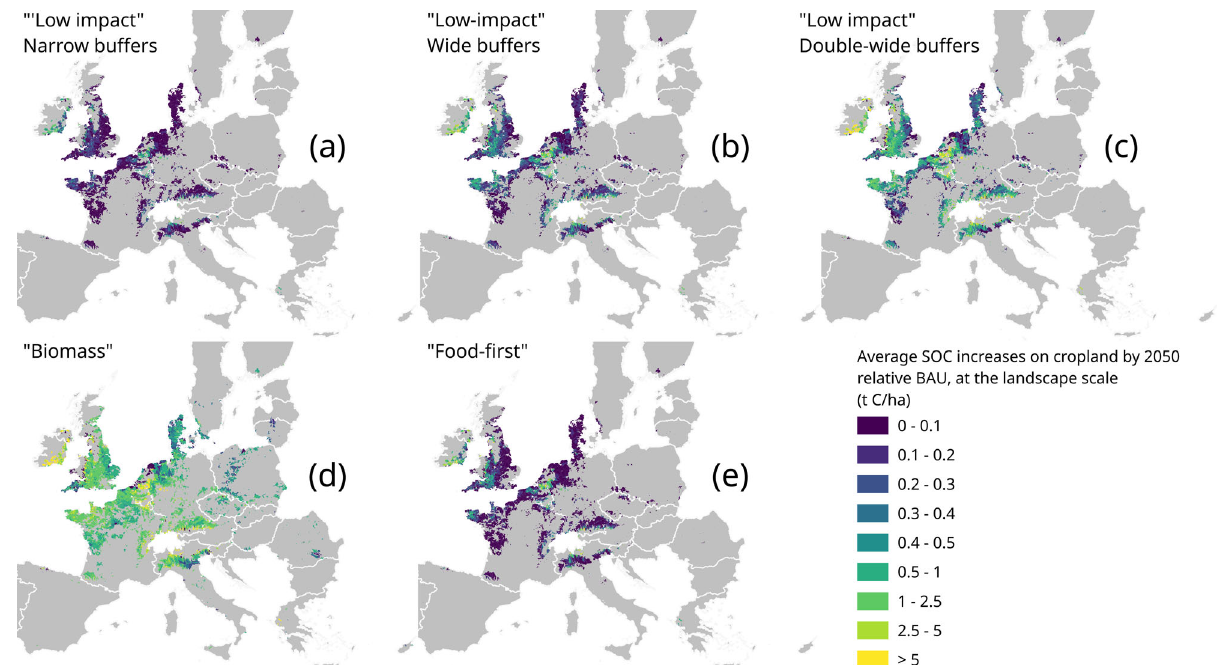
Fig. 2 Increase in soil organic carbon due to implementation of riparian buffers. Average increase in SOC on cropland by 2050, relative a business-as- usual (BAU) scenario with continued existing land-use, in each landscape, for the different deployment scenarios ( a – e ), with different riparian buffer options for the Low-impact scenario ( a – c